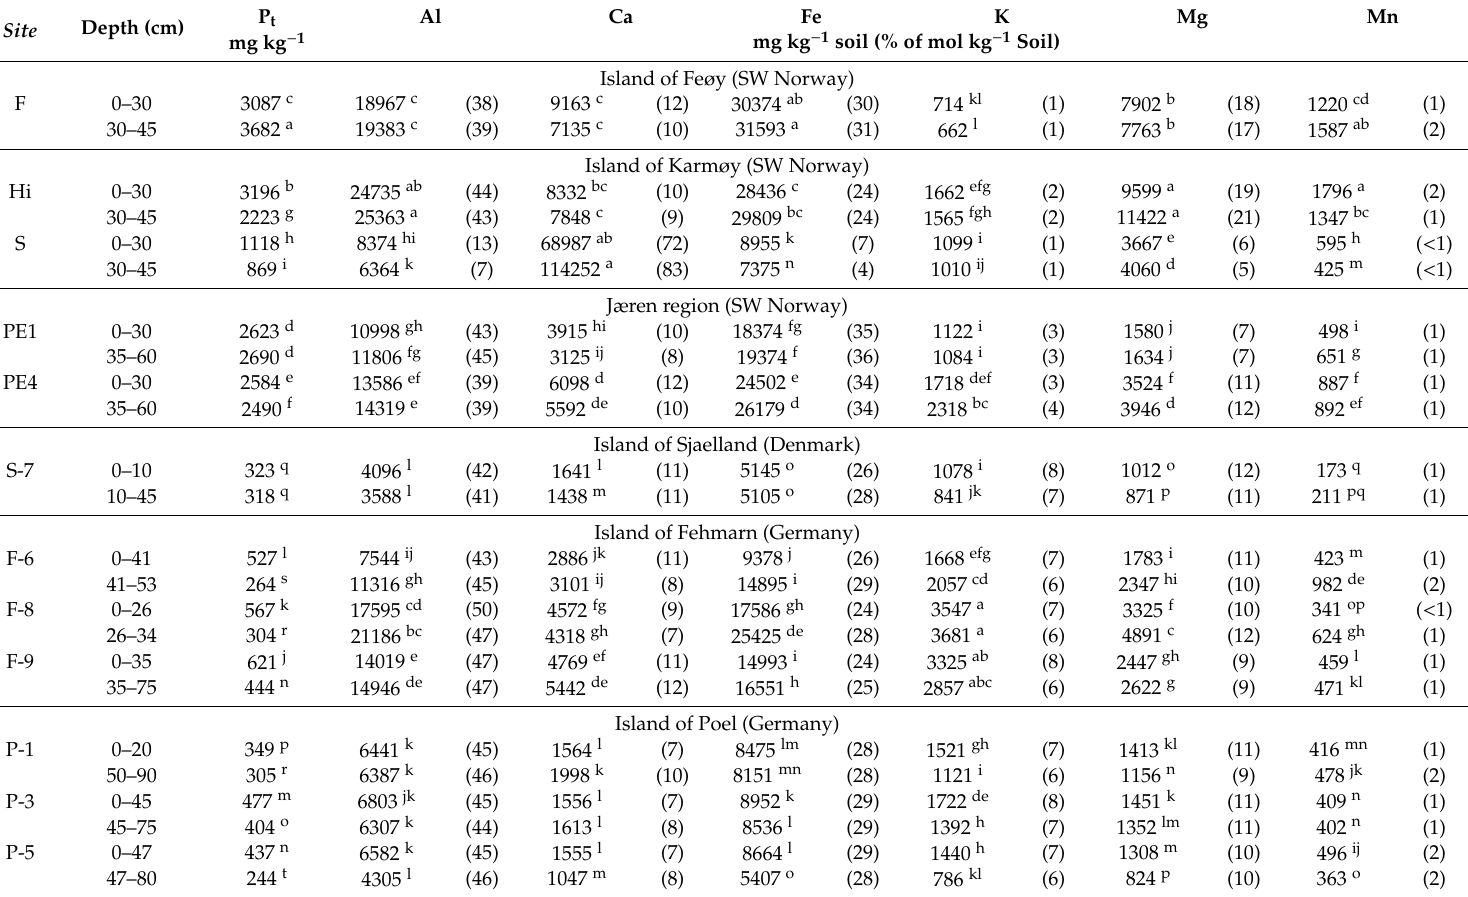
Table 1. Mean concentrations of P t , Al, Ca, Fe, K, Mg, and Mn (mg kg − 1 ). Values within the same element with the same letter are considered not significantly di ff erent. Values in parenthesis show the relative proportion of each element as percent of the sum of elements (Al + Ca + Fe + K + Mg + Mn) and were calculated by using amount of substance